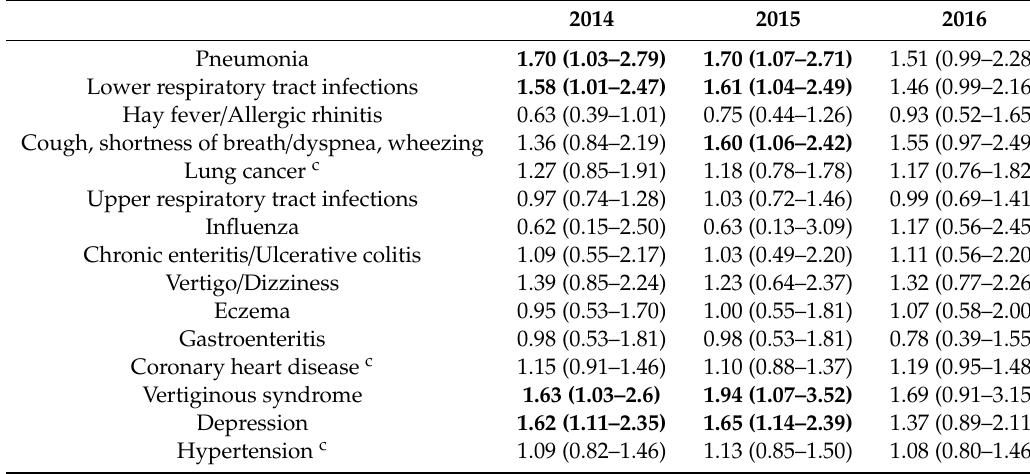
Table 4. Di ff erences (OR, 99% CI) a per year in various comorbid conditions between livestock dense areas and control areas among COPD patients b without comorbid asthma (statistically significant results in bold)